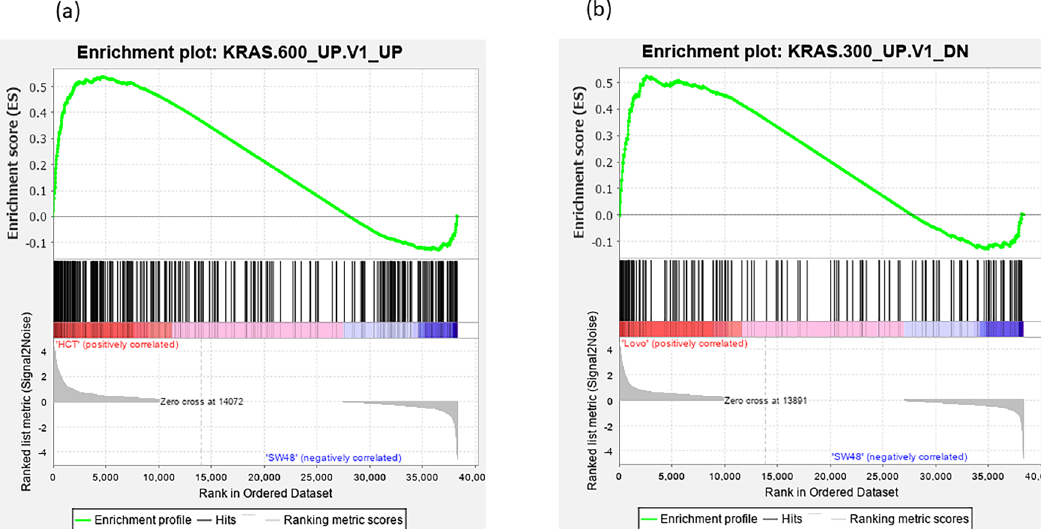
Figure 3. GSEA analysis for oncogenic signature gene sets. ( a ) Enrichment plot of GSEA analysis for HCT- 116. ( b ) Enrichment plot of GSEA analysis for LoVo. Enrichment plot on the whole transcriptome of the CRC cell lines showing the up-regulation of KRAS signaling oncogenic signature in HCT-116 vs SW48 and LoVo vs SW48. FDR < 25% after 1000 random permutations was set as the cut-off